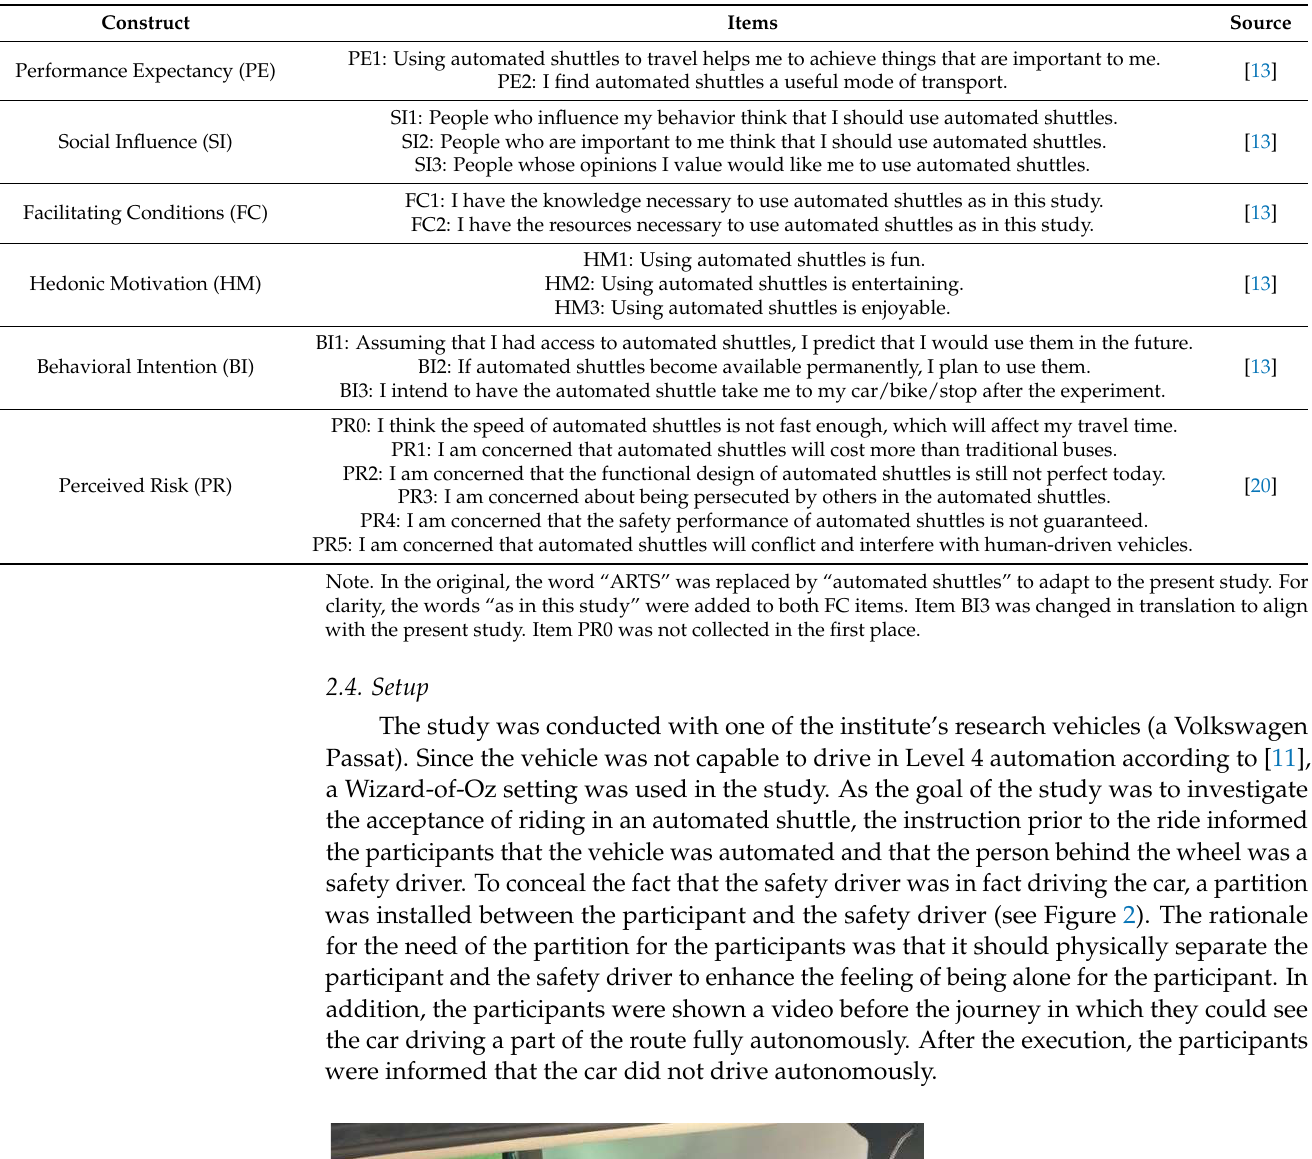
Table 1. Items of the questionnaire for the scales of the UTAUT-2.